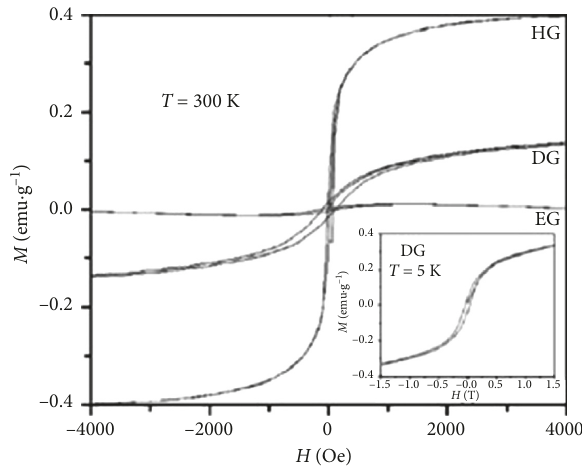
Figure 9: Magnetic